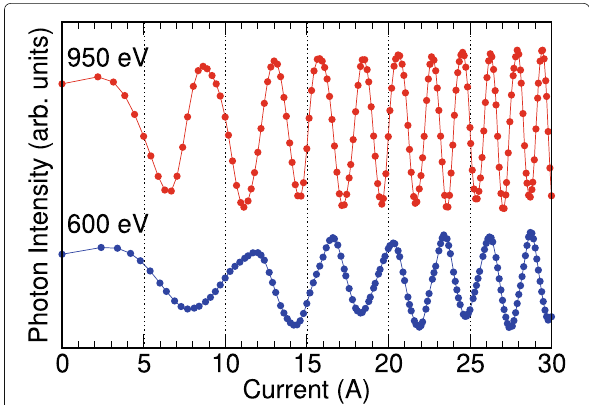
Fig. 20 Path length of EMPS1 as a function of current. The black line is the fitted curve with the quadrant